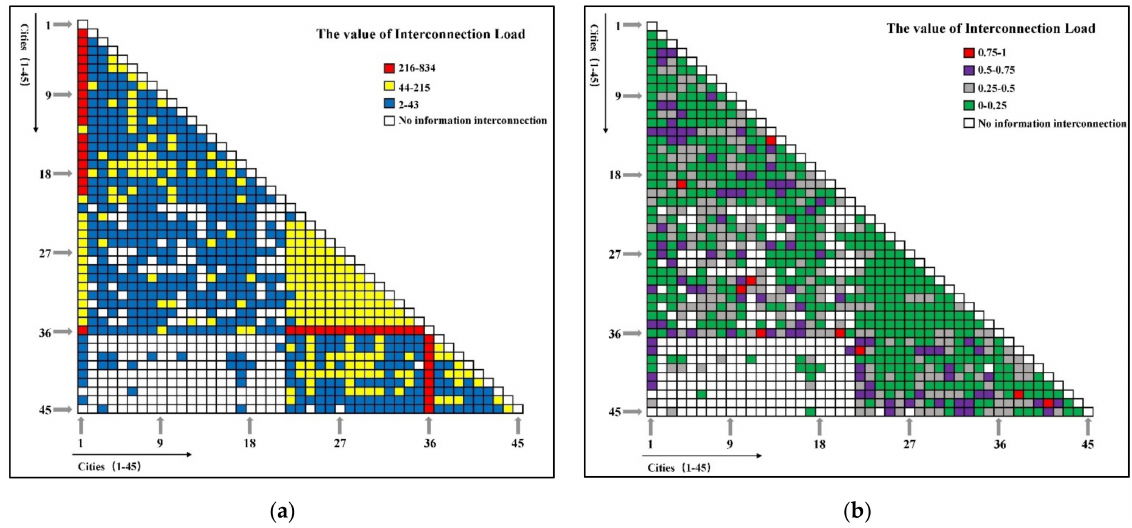
Figure 4. Pattern of interconnection. ( a ) Pattern of interconnection interrelation quantity, ( b ) Pat- tern of interconnection imbalance. The cities corresponding to the numbers 1–45 are the same as in Figure 1.